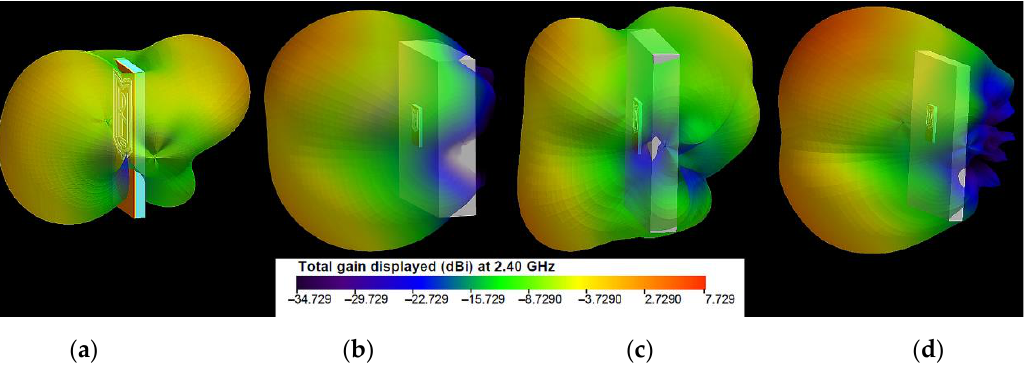
Figure 5. Simulated 3D radiation patterns of the antenna at 2.40 GHz: ( a ) in free space; ( b ) on the human-body model; ( c ) on the notebook model; ( d ) on the laptop model.